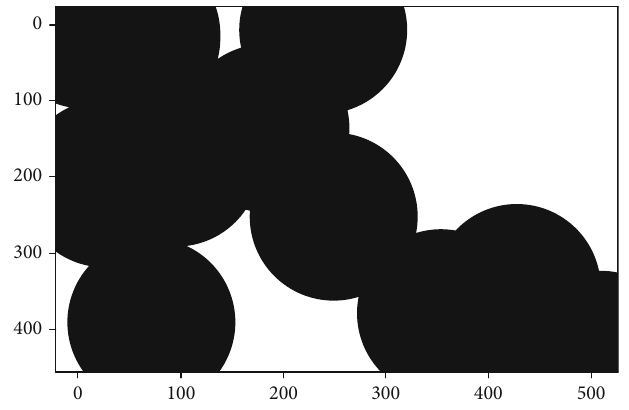
Figure 5: Illustration of the array that represents the ranges of the